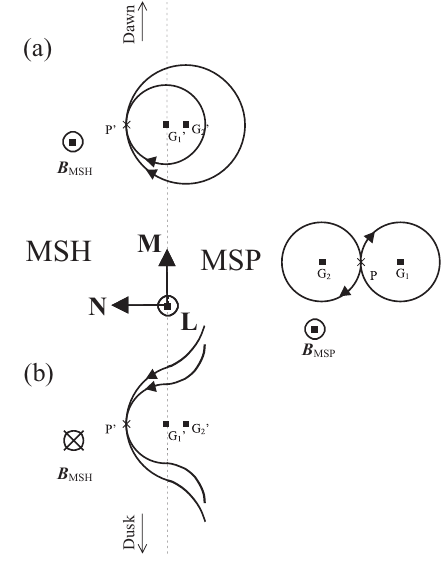
Fig. 5. Sketch of ion orbits for ( a ) northward and ( b ) southward IMF in the ( N , M ) plane when neglecting the effect of the convec- tion, magnetic field-gradient and curvature